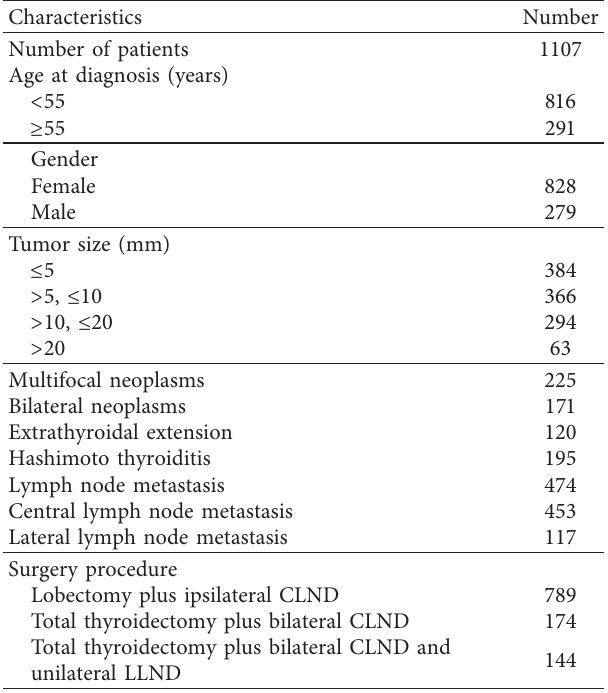
Table 1: Clinicopathologic characteristics of patients.